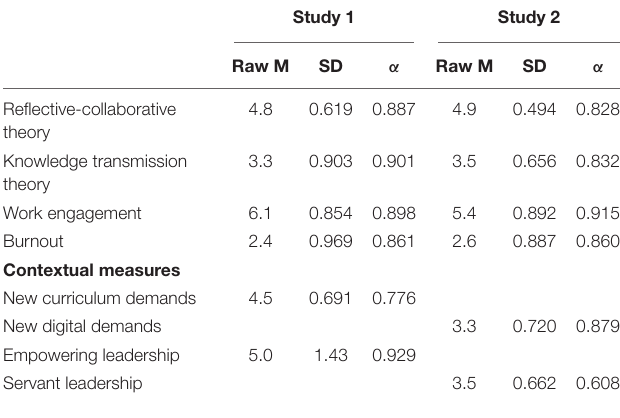
TABLE 2 | Raw M, SD, and α for Study 1 and Study